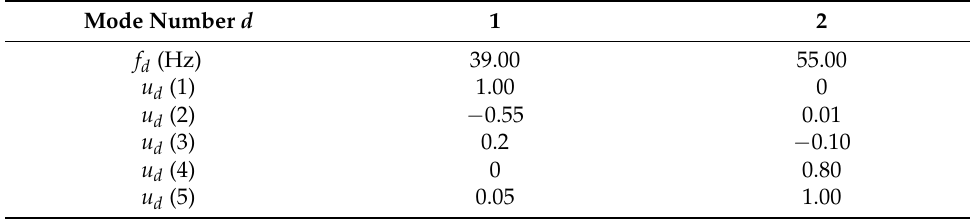
Table 3. Desired natural frequencies and mode shapes.